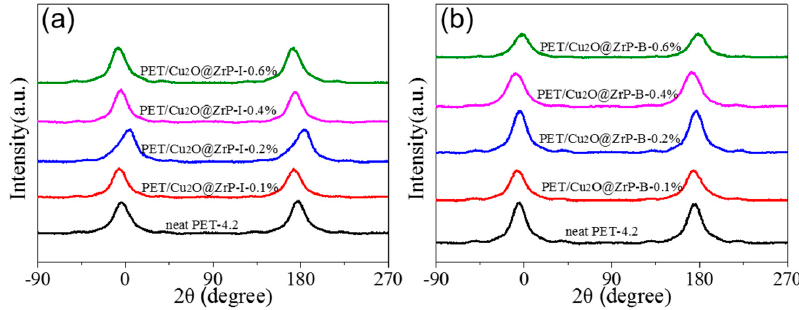
Figure 6. WAXD curves of ( a ) PET/Cu 2 O@ZrP-I and ( b ) PET/Cu 2 O@ZrP-B drawn fibers.